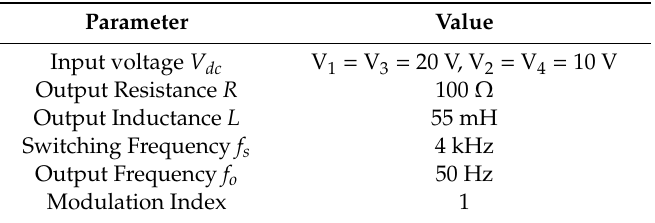
Table 4. Parameters for simulation and